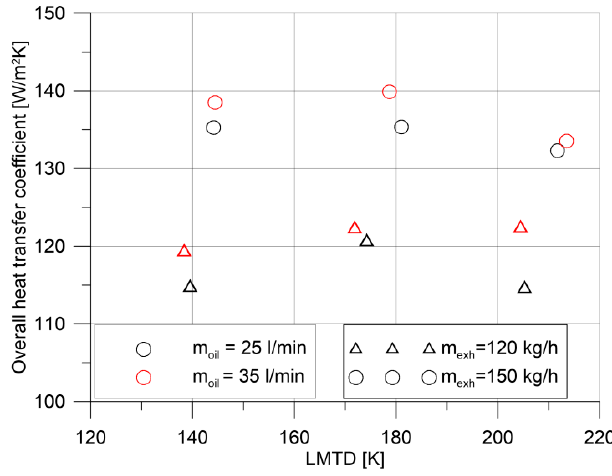
Figure 5. Heat exchanger characterization: overall heat transfer coefficient vs. LMDT.